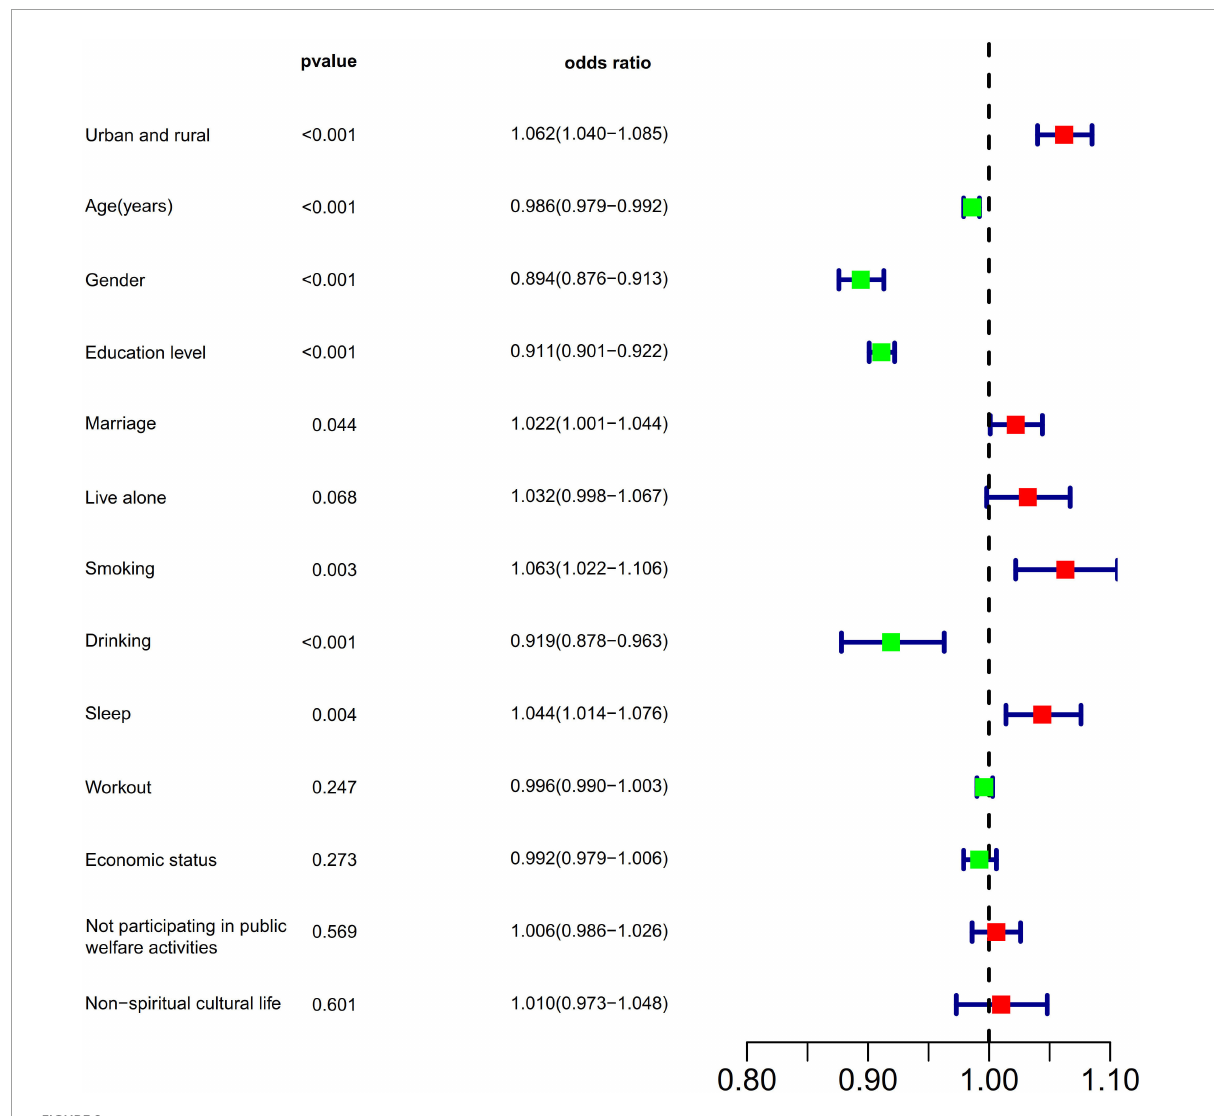
FIGURE2 Multivariable logistic proportional regression analyses show associations between risk factors and CCVD.